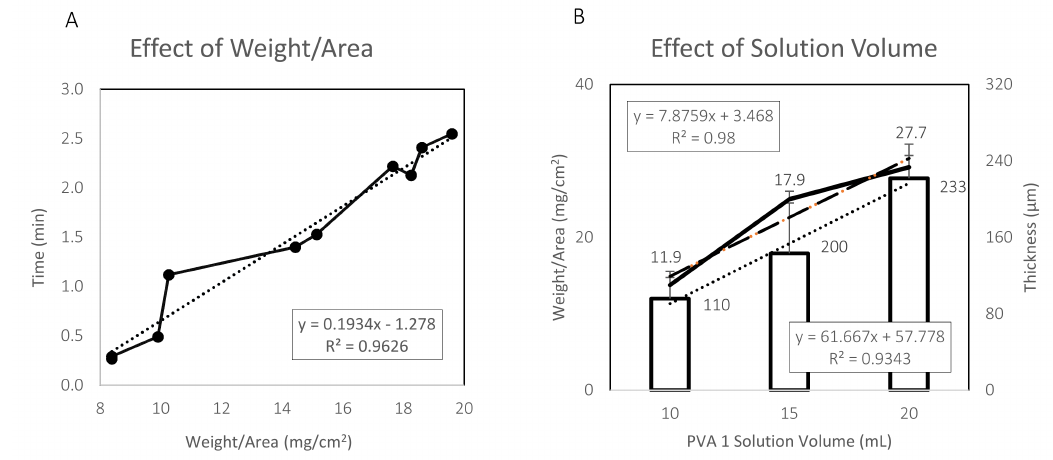
Figure 5. PVA 1 film weight and thickness characterization. ( A ) Effect of weight of 7.5% ( w/v ) PVA 1 film on dissolution time when immersed in 100 µ L of DI-water droplet on parafilm. ( B ) Weight and thickness as a function of PVA 1 solution